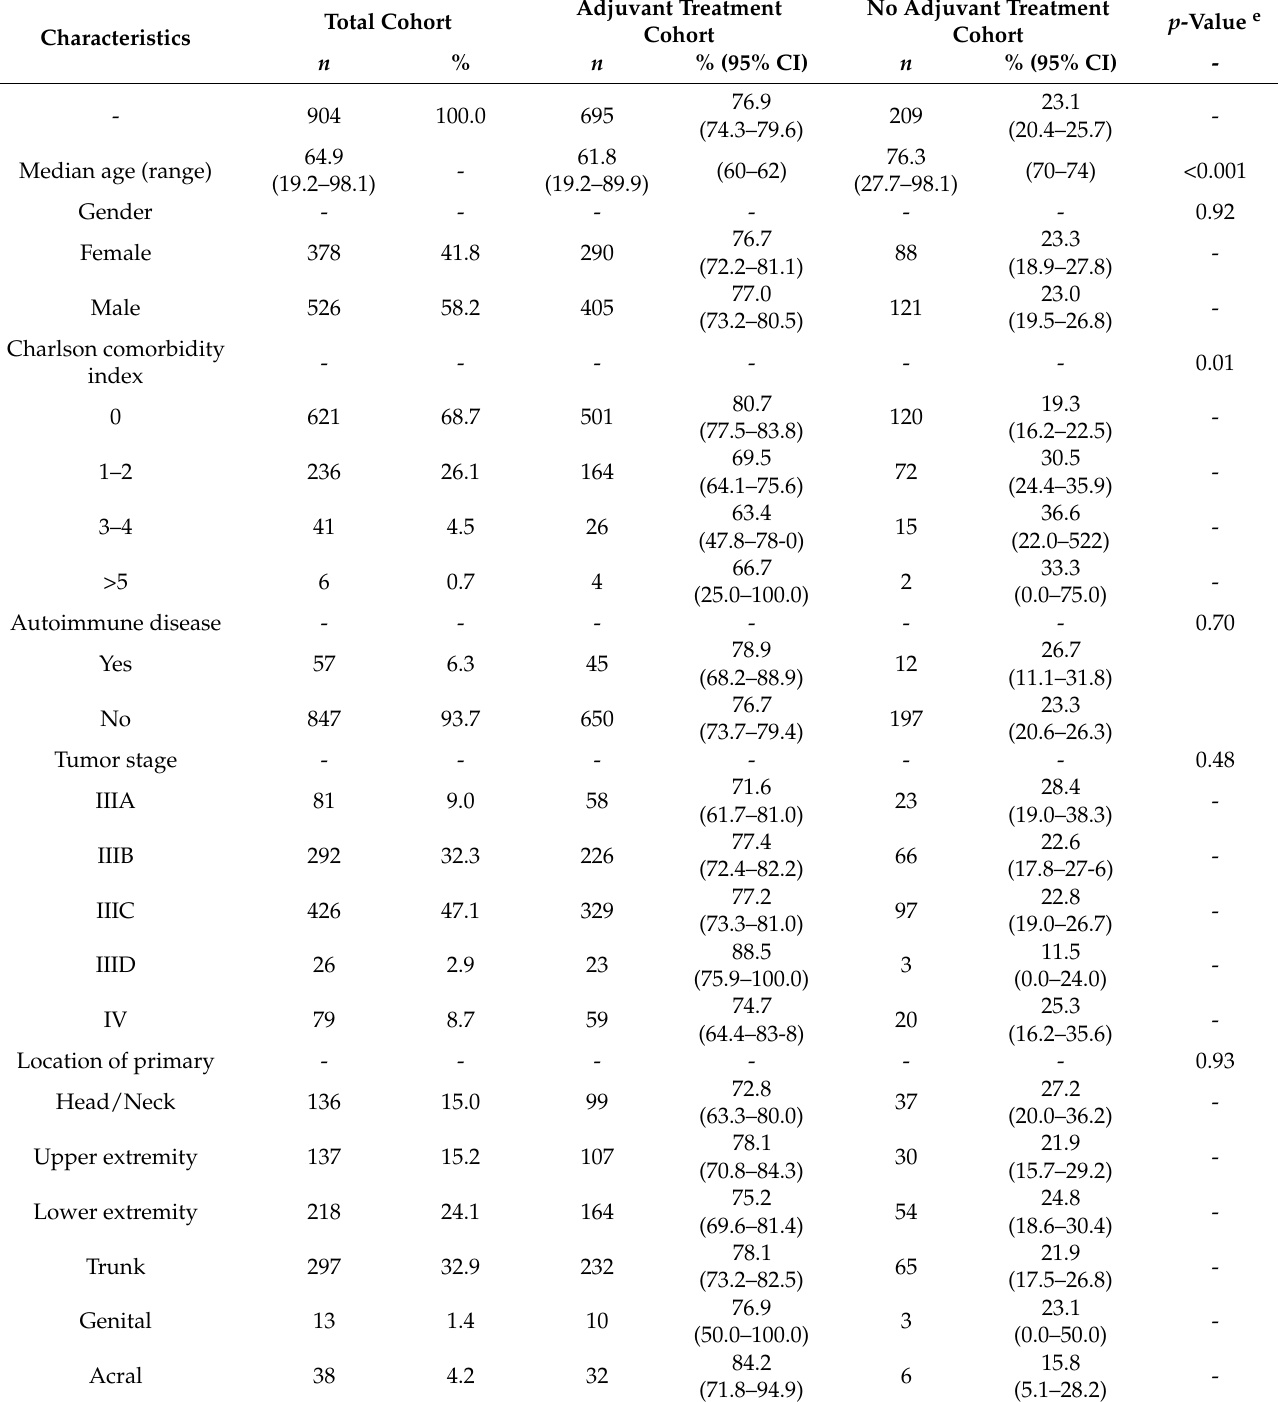
Table 1. Patient characteristics of the total cohort at the time of decision for or against systemic adjuvant treatment.